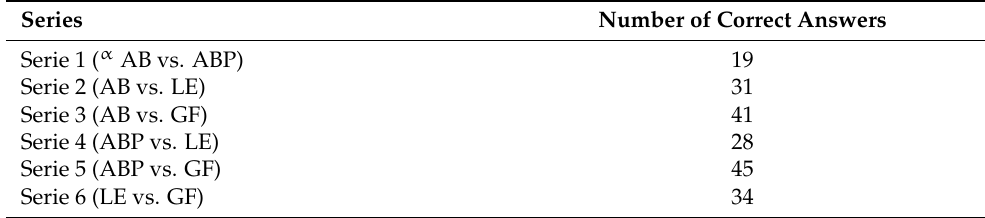
Table 3. Results of the sensory evaluation, by triangle test (54 panelists), of the series